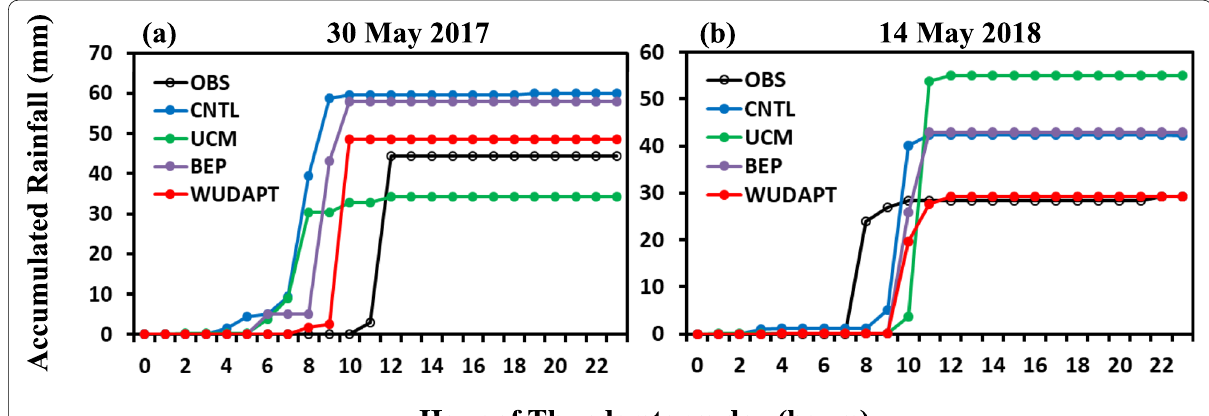
Fig. 3 a Hourly accumulated rainfall (mm) from all the experiments along with the Bhubaneswar meteorological station observation (OBS) for 30 May 2017 case. b Same as ( a ) but for 14 May 2018